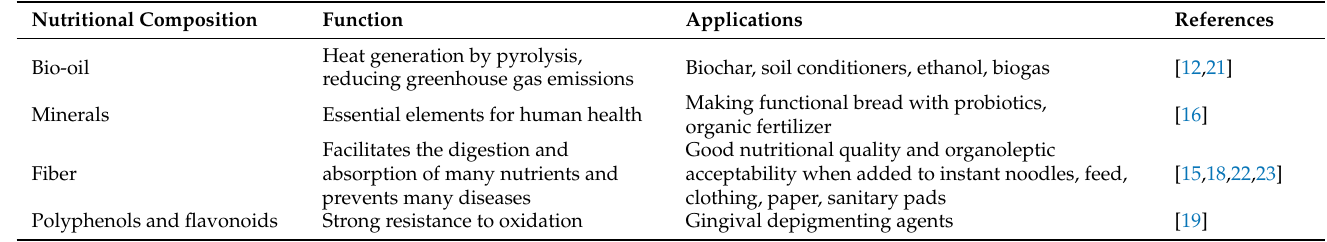
Table 1. Components, functions and applications of banana stems and